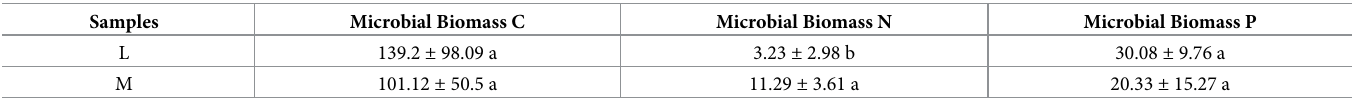
Table 3. Soil microbial biomass C, N, and P between moss- (M) and non-moss growth(L) areas in litchi orchard (mg � kg − 1 ).